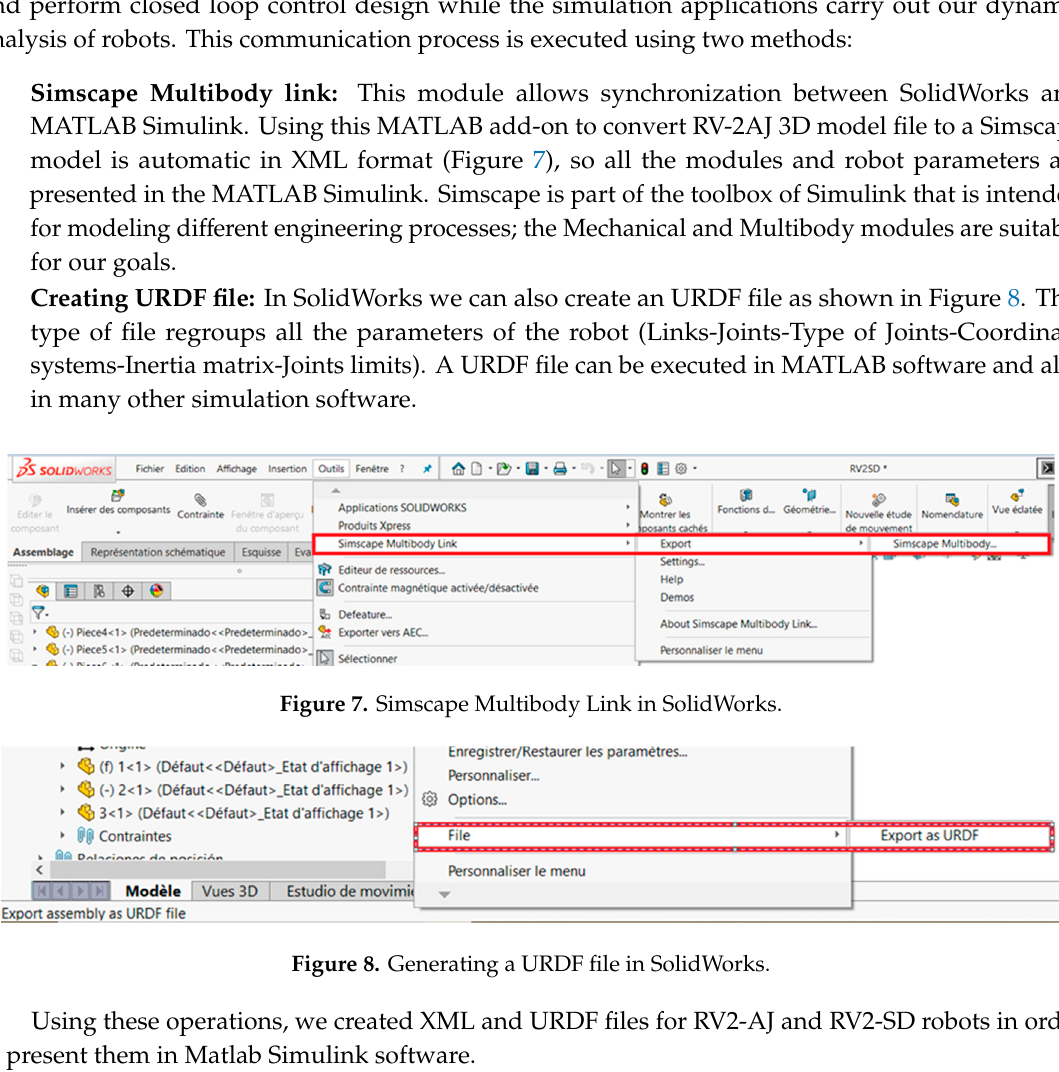
Figure 8. Generating a URDF file in SolidWorks.